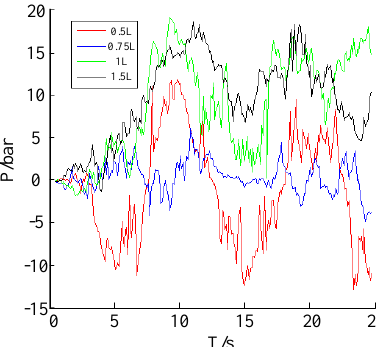
Figure 11. The pressure fluctuations of the cylinder under different volumes of accumulator.